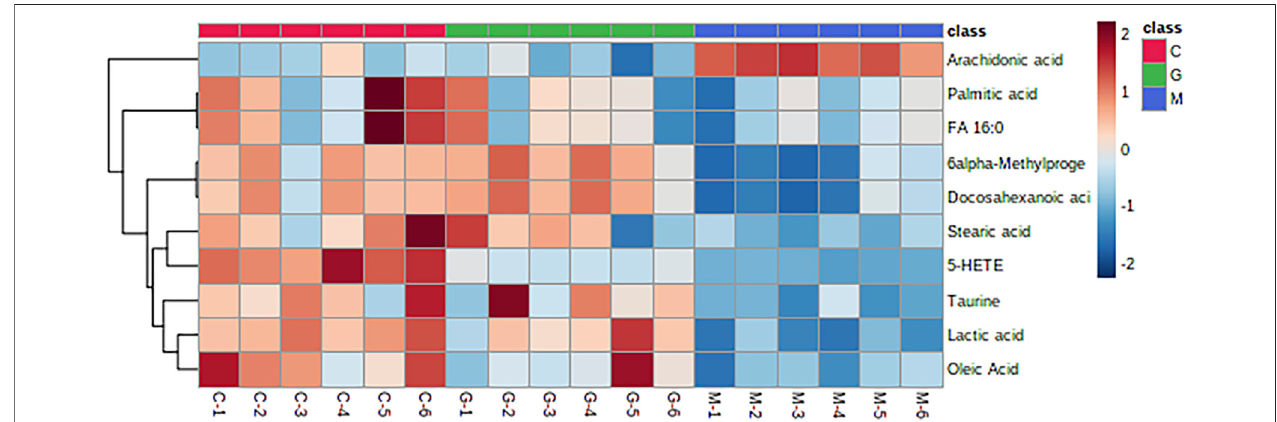
FIGURE 9 | Heatmap of hierarchical clustering analysis for three test groups of Control rats (group C), Model rats (group M) and Guizhi Fuling Capsules administration rats (group G), the abscissa represents different experimental groups, the ordinate represents the differential metabolites investigated, the color represents the relative content of the corresponding metabolite in the corresponding sample, red represents the higher content in the sample, and blue represents the lower content.